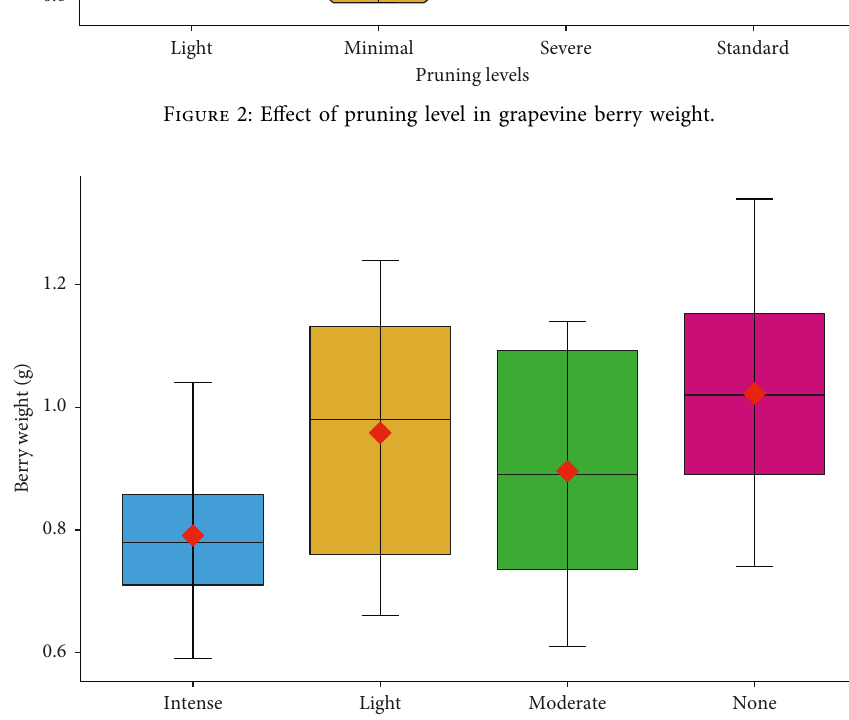
Figure 3: Influence of post-veraison water stress in grapevine berry